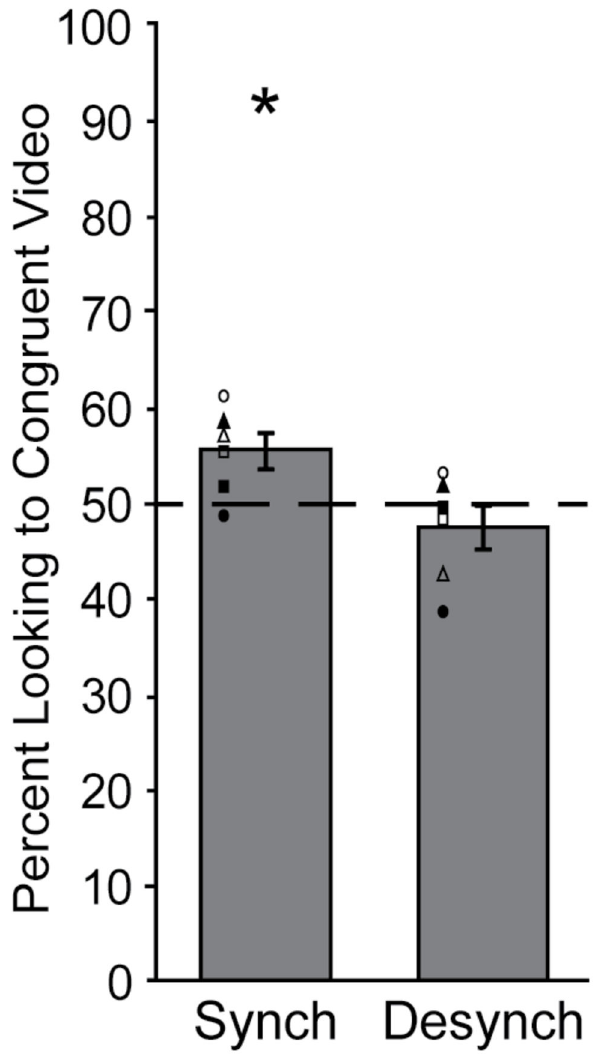
time (± s.e.m.) to the congruent stimulus video in the Synchronized and Desynchronized conditions. The dashed line represents chance level of 50%. Values greater than 50% represent greater looking to the congruent video and values less than 50% represent greater looking to the incongruent video. Symbols represent individual data points for males (filled) and females (open). (*) p <